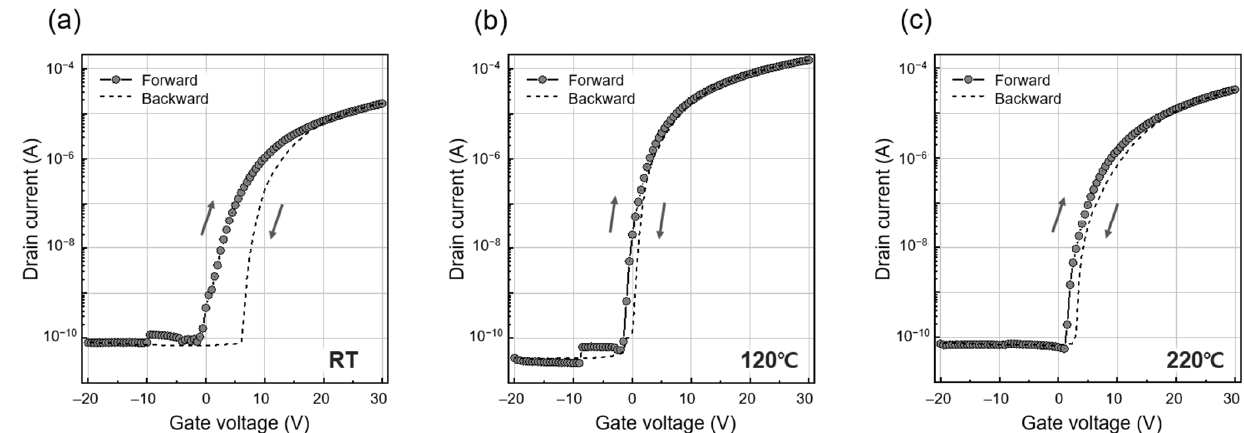
Figure 4. Transfer curves of the ZTO TFTs pre-annealed at ( a ) RT, ( b ) 120 °C, ( c ) 220 °C.